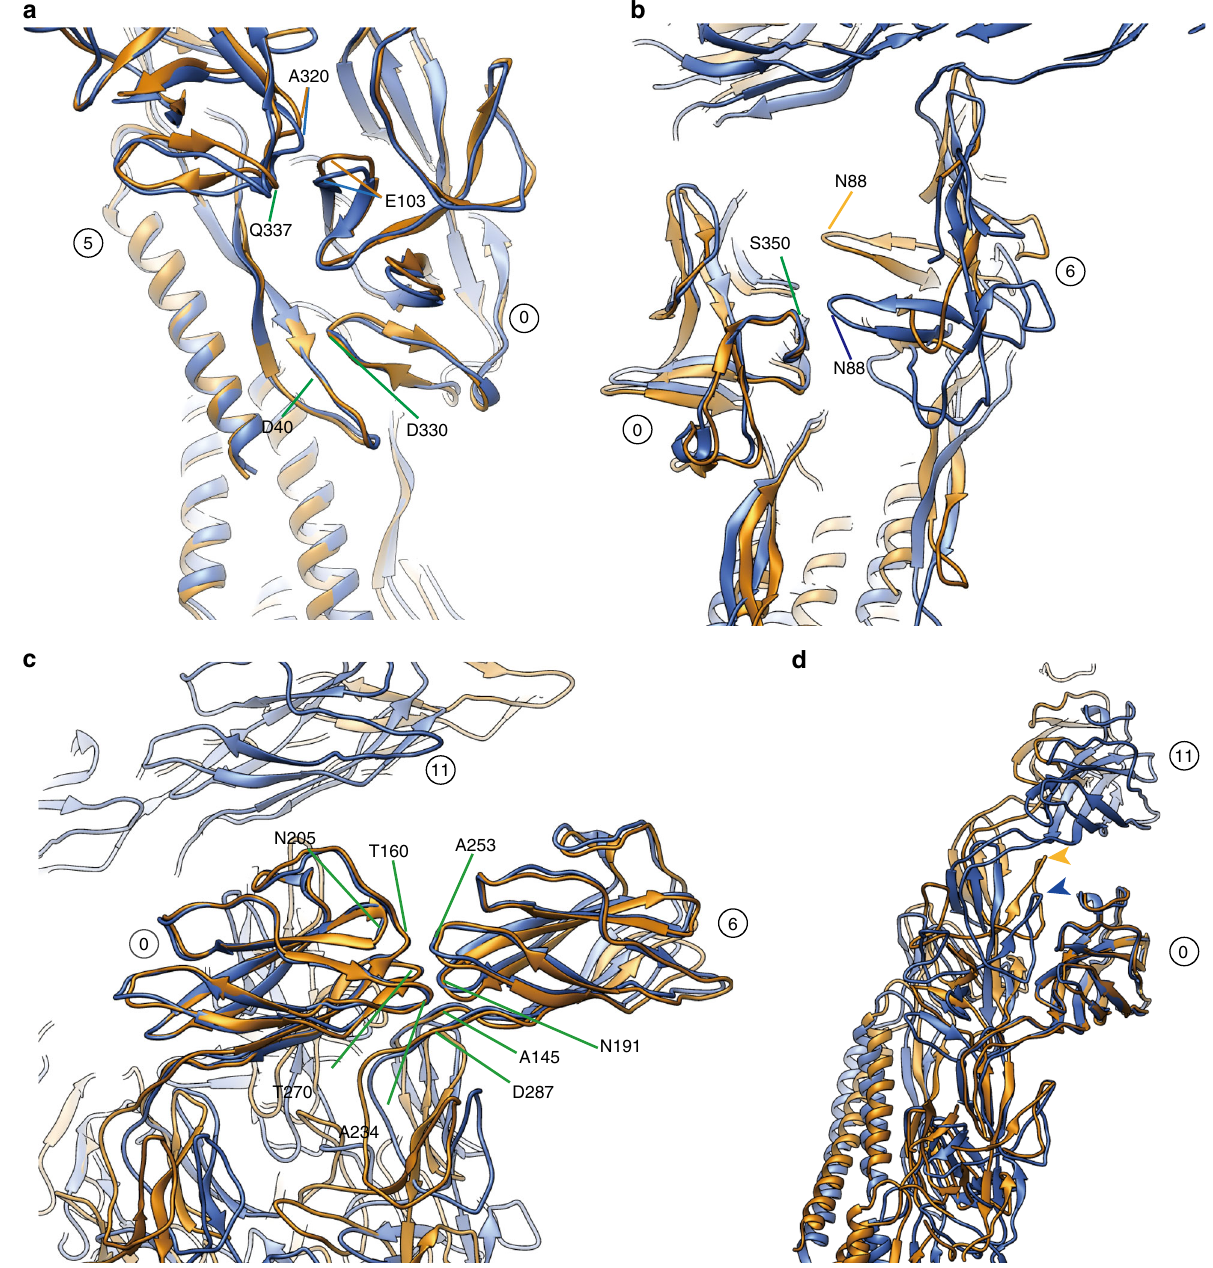
Fig. 4 Changes in intersubunit interactions upon proto fi lament compression and extension. a Constant interactions between domain D1 of subunit 0 and domain D0 – Dc of subunit 5. b Relative sliding shift between domain D1 of subunit 0 and domain D1 of subunit 6. c Constant interactions between the D2 domains of subunits 0 and 6 along the 6-start helical directions on the surface of the hook. d Relative sliding shift along the proto fi lament between domain D2 of subunit 0 and the triangular loop of domain D1 of subunit 11. The arrowheads indicate the triangular loop. color codes of the ribbon diagrams are the same as Fig. 2, blue for the shortest (compressed) and orange for the longest (extended) proto fi